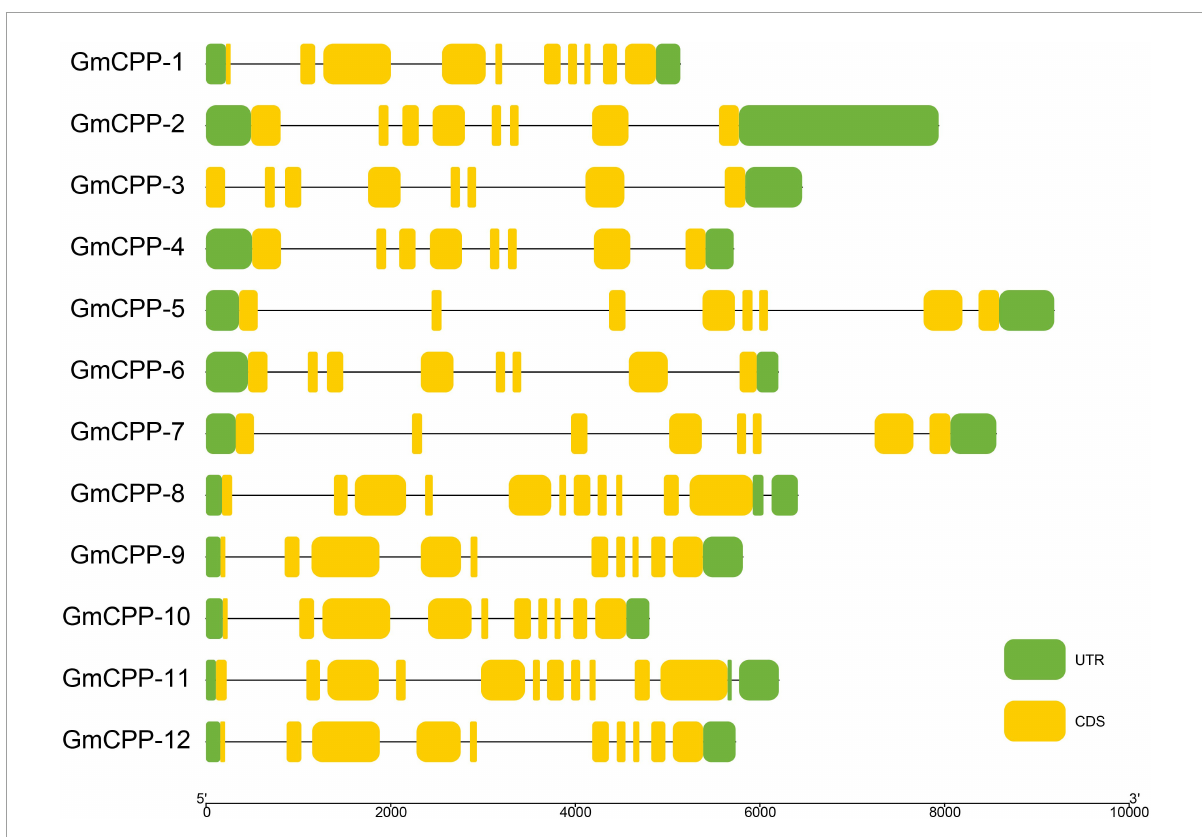
FIGURE3 Gene structure display of GmCPP . Exon/intron structure display of GmCPP genes; Green color shows the upstream and downstream region, yellow color shows exons, black lines show